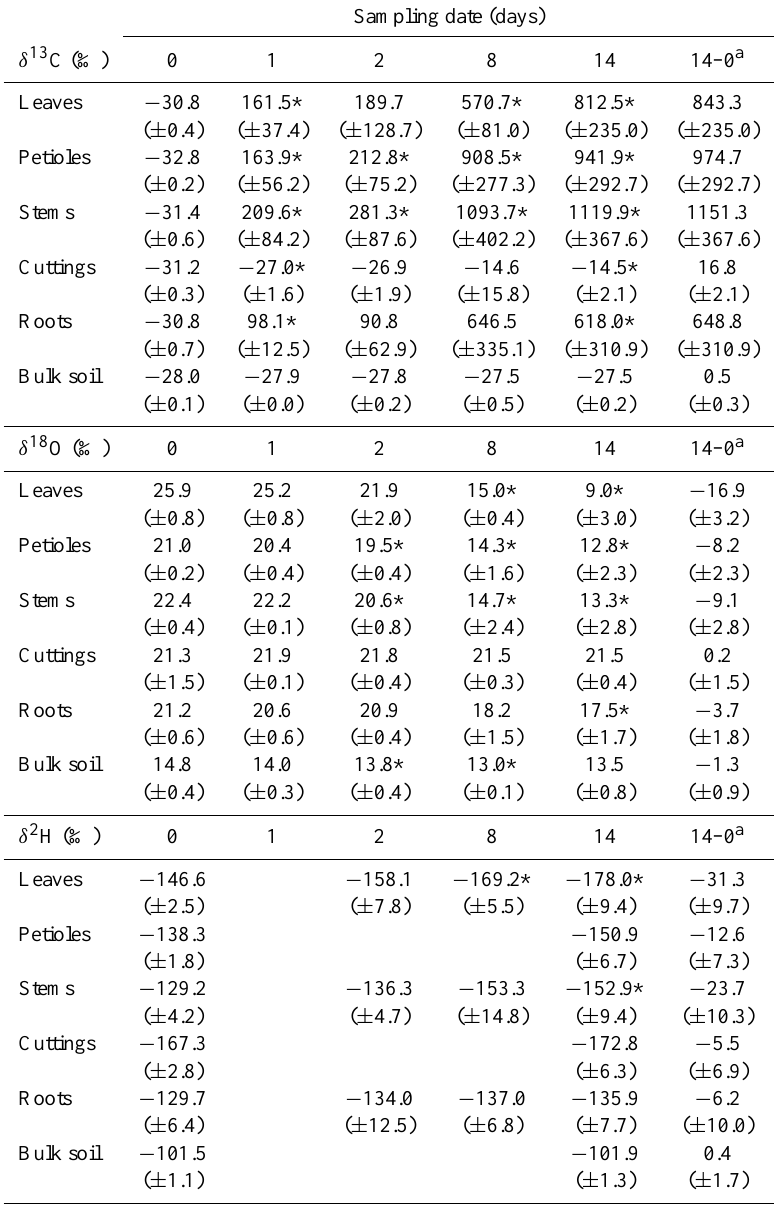
Table 2. Multi-isotope labelling of bulk OM. δ 13 C, δ 18 O and δ 2 H signatures (in ‰) of the plant–soil compartments (three replicates ± 1 standard deviation) measured before and after 1, 2, 8 and 14 days of continuous labelling. A significant enrichment ( δ 13 C) and